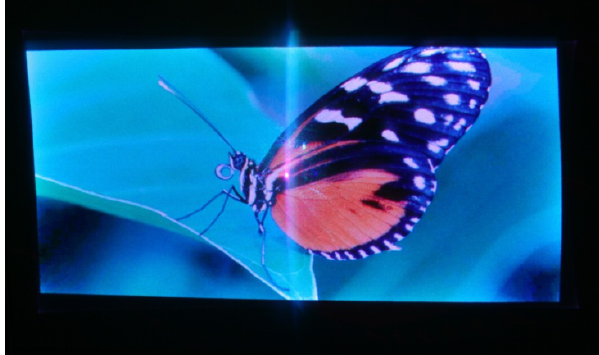
Figure 21. Lissajous-laser-projection of a 512 × 1,024 pixel image based on a biaxial scanner with a plane glass window. The bright spot in the center of the image is caused by a direct reflex of the incoming laser beam at the glass lid of the MEMS